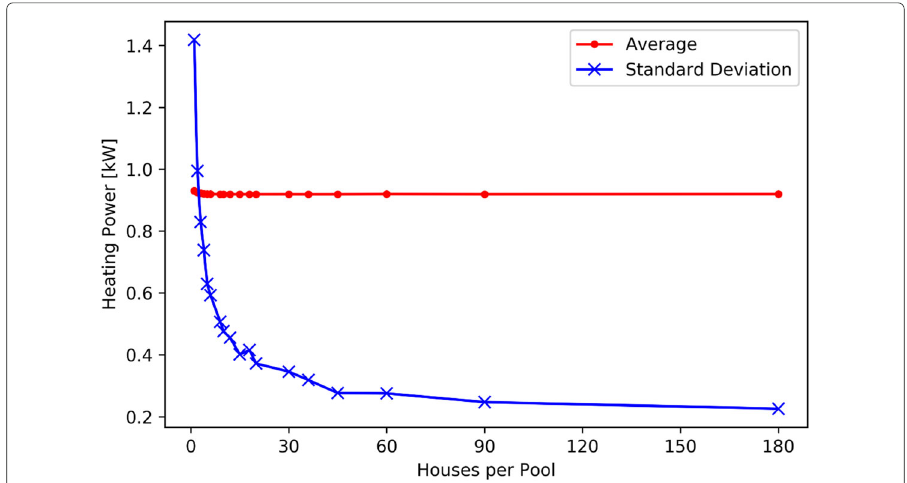
Fig. 8 Average and Standard Deviation of the distributions of the average space heating and hot water power consumption (over 15 minutes) of 180 households in January